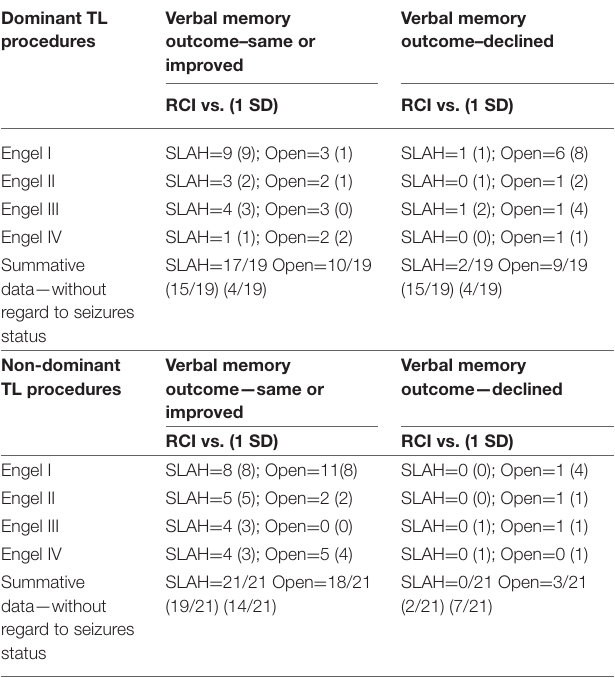
TABLE 2 | Change in verbal memory by surgery type, laterality of procedure, and seizure outcome using reliable change and standard deviation